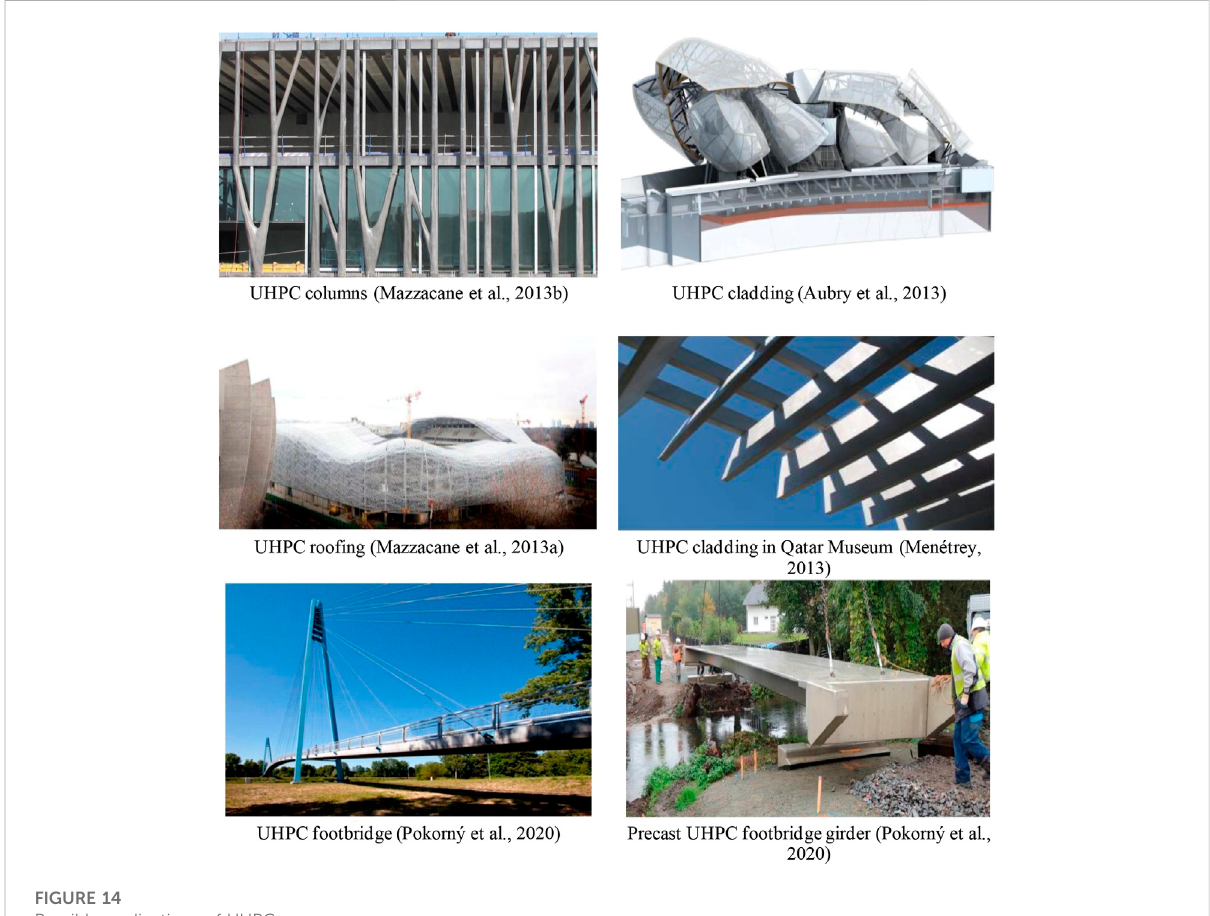
FIGURE 14 Possible applications of